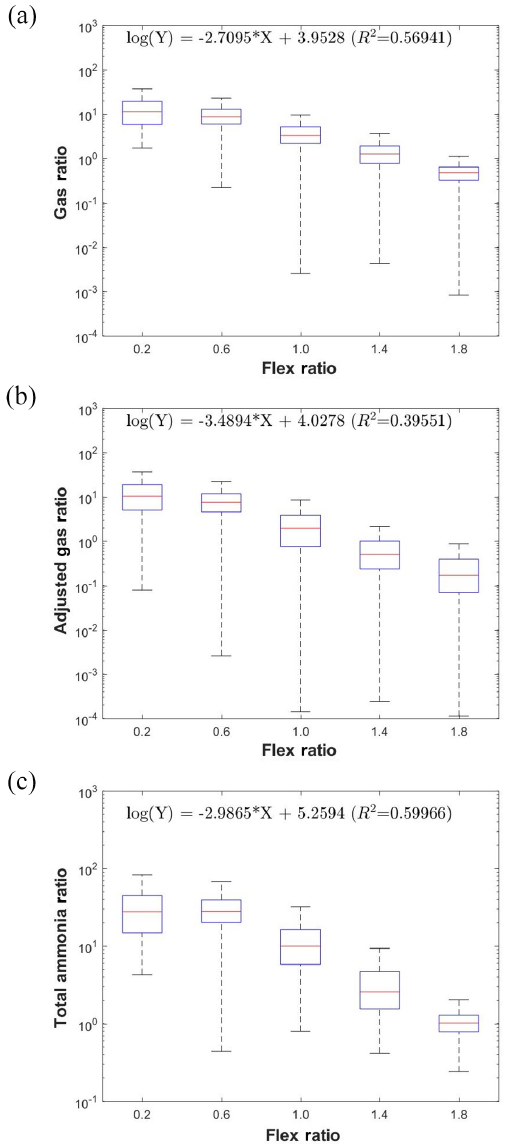
Figure 8. Development of observable responsive indicators for PM 2 . 5 chemistry based on log-linear regressions between observ- able indicators and the